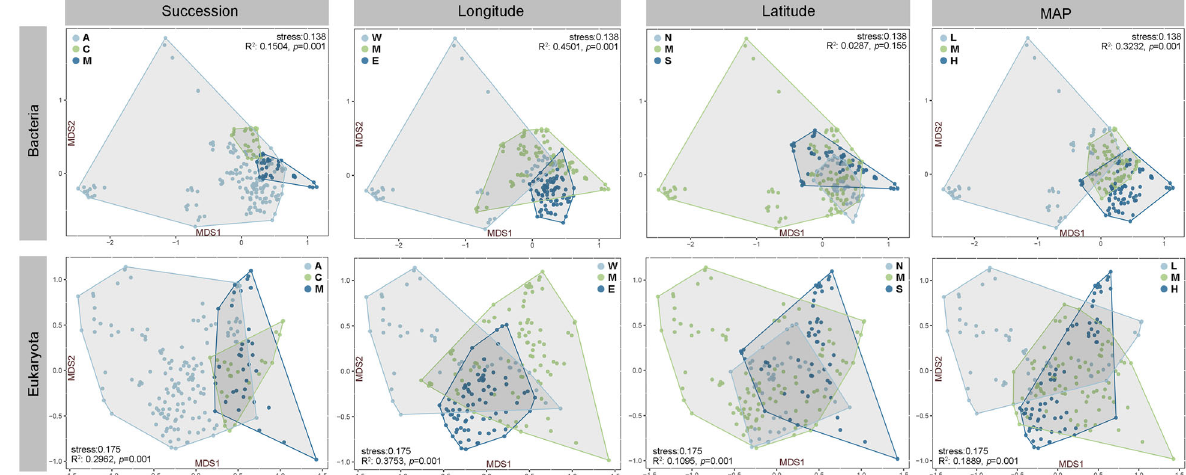
Fig. 1 The nonmetric multidimensional scaling of bacterial and eukaryotic communities based on Bray – Curtis distance at operational taxonomic unit level. The NMDS was performed based on succession, longitude, latitude, and mean annual precipitation (MAP), each of which was divided into three groups. Each dot represented a sample, light blue, green, and dark blue corresponded to algae-dominated crust (A), lichen-dominated crust (C), and moss-dominated crust (M) for succession; West (W, E87° – 98°), Mid-longitude (M, E98° – 109°), East (E, E109° – 120°) for longitude; North (N, N42° – 45.5°), Mid-latitude (M, N38.5° – 42°), and South (S, N35° – 38.5°) for latitude; Low-MAP (L, 0 – 150 mm), Mid-MAP (M, 150 – 300 mm), and High-MAP (H, 300 – 450 mm) for MAP, respectively. ANOSIM analysis and permutation test (999) were used to test for signi fi cant differences among